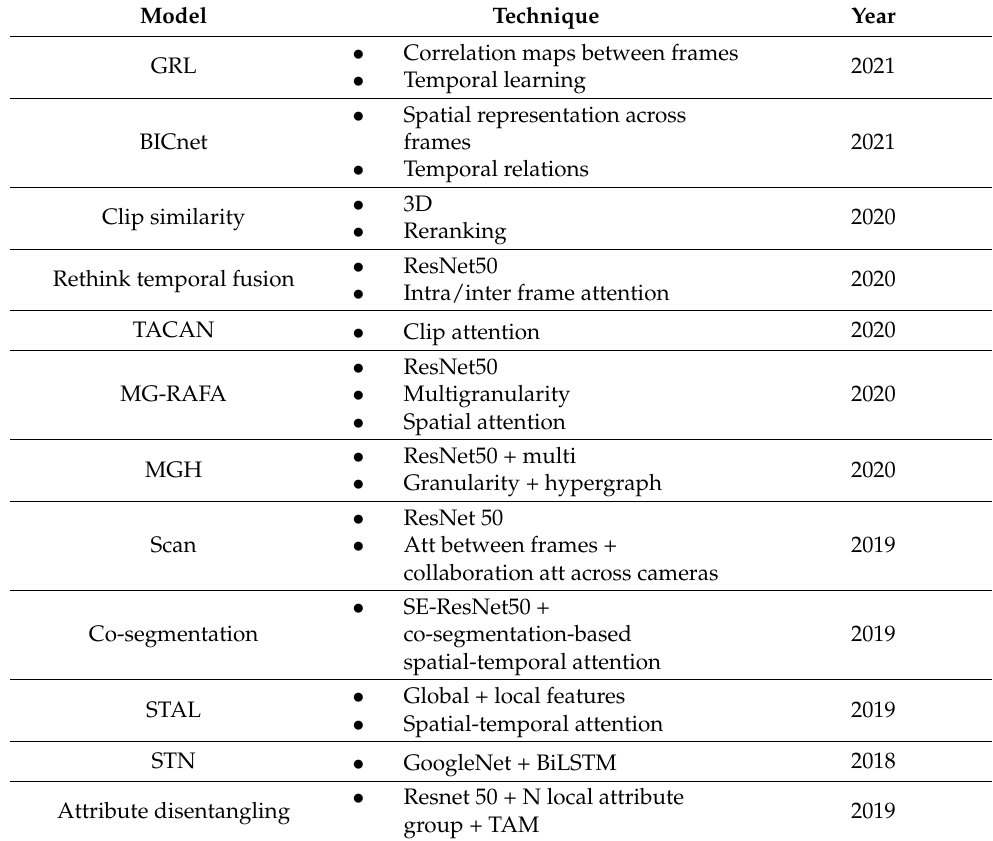
Table 2. Summary of Recent Video-Based Person Re-Identification Techniques.